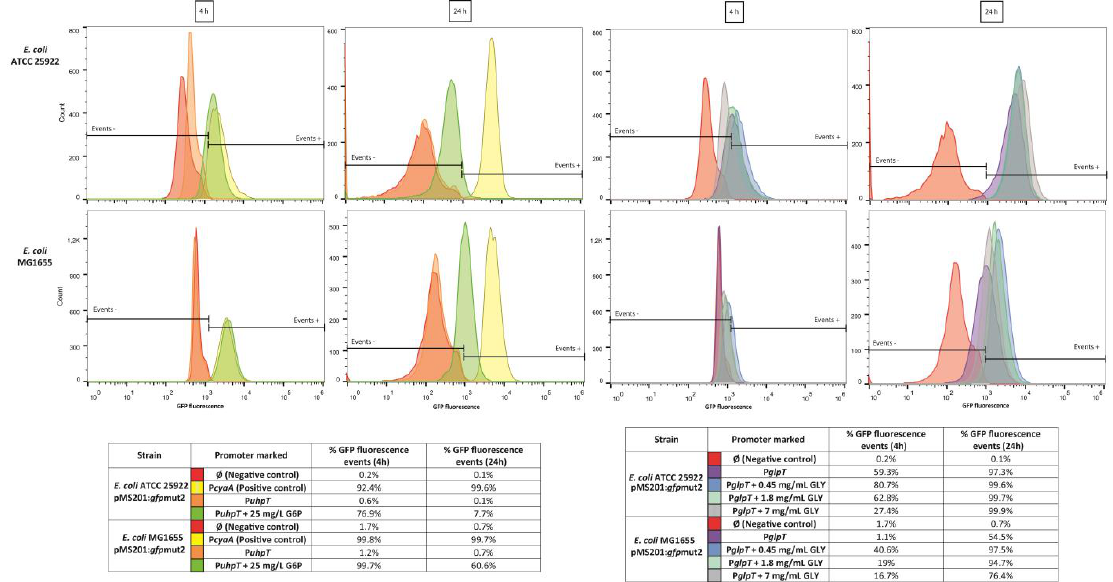
Figure 2. Transcriptional analysis of glpT, uhpT, and cyaA expression in E. coli ATCC25922 and E. coli MG1655 at 4 h and 24 h. GFP fluorescence in E. coli cells carrying the transcriptional fusions (P glpT - gfp, P uhpT -gfp, and P cyaA -gfp ) and grown in MHB alone or supplemented with glucose-6-phosphate (G6P) or glycerol (GLY). The red and yellow areas identify the regions considered negative and positive for the fluorescence signal, respectively (as assessed with cells carrying the empty pMS201vector or with P cya - gfp fusion).